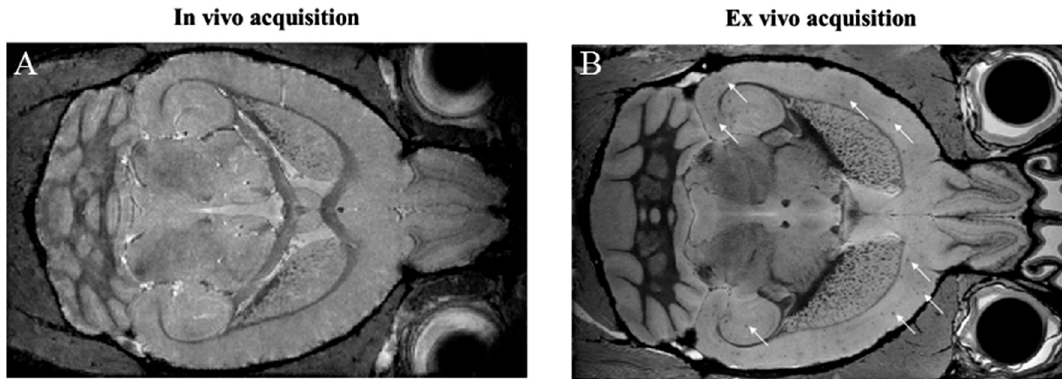
Figure 3. Alzheimer’s disease (AD) mouse brain (12 months old) T 2 *-weighted MRI images acquired at 7T without a contrast agent. No direct amyloid plaque detection is possible in vivo ( A ) while the absence of blood and the highest resolution make amyloid plaques clearly visible ex vivo ( B ). Three-dimensional (3D) gradient-echo sequences: In vivo parameters: echo time 4 ms, repetition time 90 ms, echo spacing 3 ms, resolution 60 × 60 × 60 µm 3 , matrix size 280 × 180 × 120, number of echoes